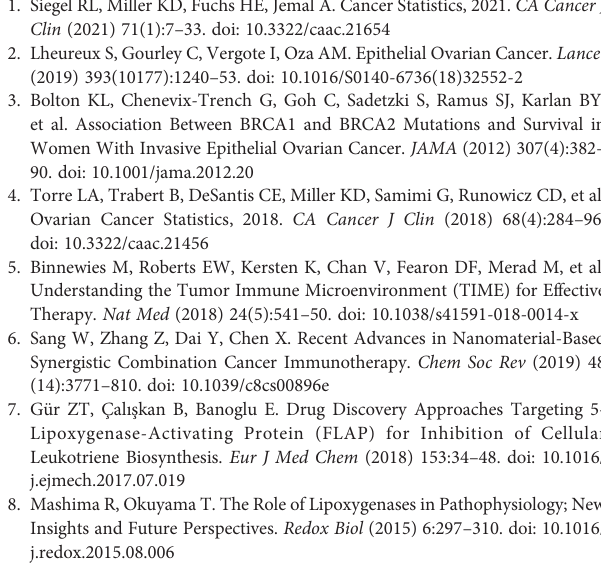
Supplementary Figure 1 | Single-cell RNA sequencing analysis of ALOX5AP expressionandimmunocytesin fi ltrationusingTISCHdatabase. UMAP plotofallthe single cells, with each color coded for (A) 3 major cell types, (B) 5 minor cell types, and (C) ALOX5AP expressed